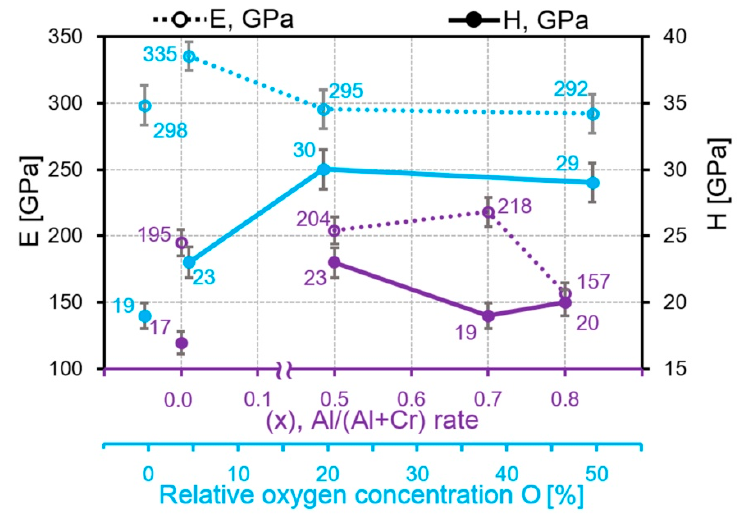
Figure 14. The dependences of E and H from the aluminum content in the AlCrN coatings and on the oxygen content in the CrON coatings.